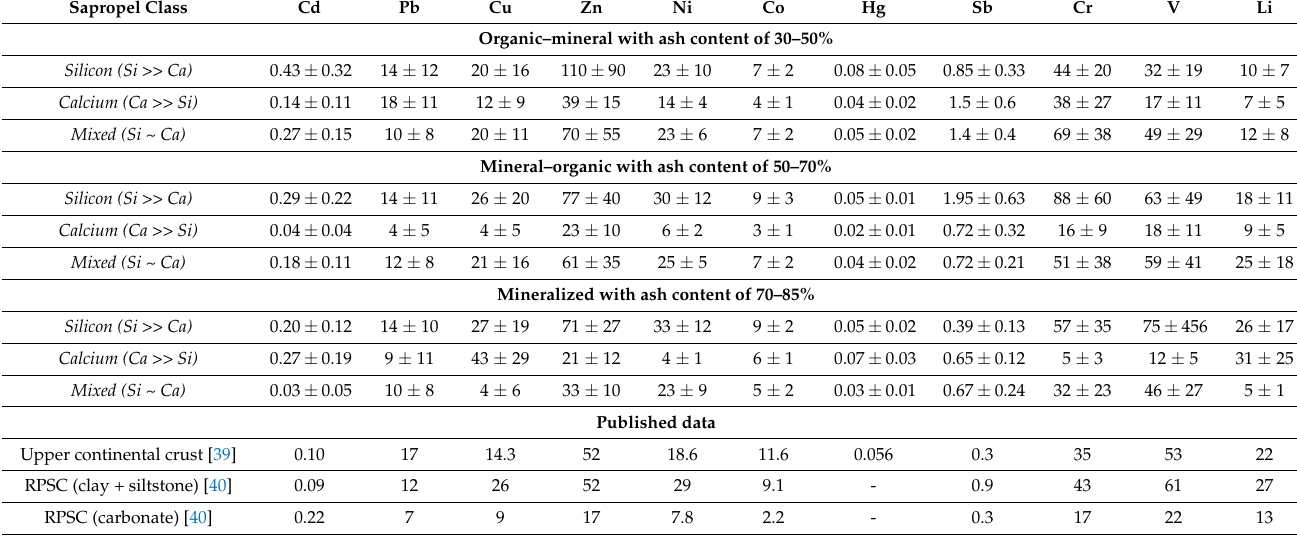
Table 2. Average content of trace elements (mg/kg) in sapropels of lakes of various types and classes in the south of Western Siberia (arithmetic mean ± standard